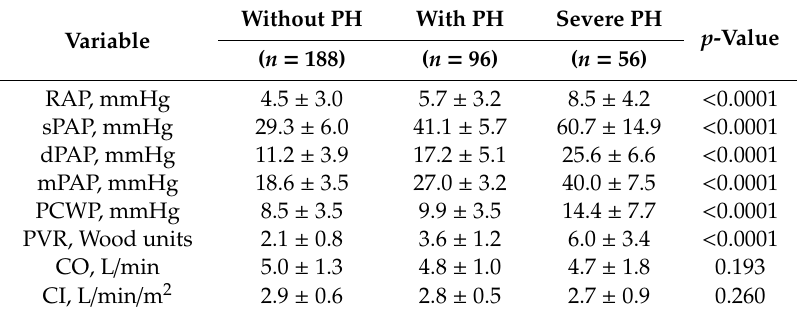
Table 3. Hemodynamic parameters of the study